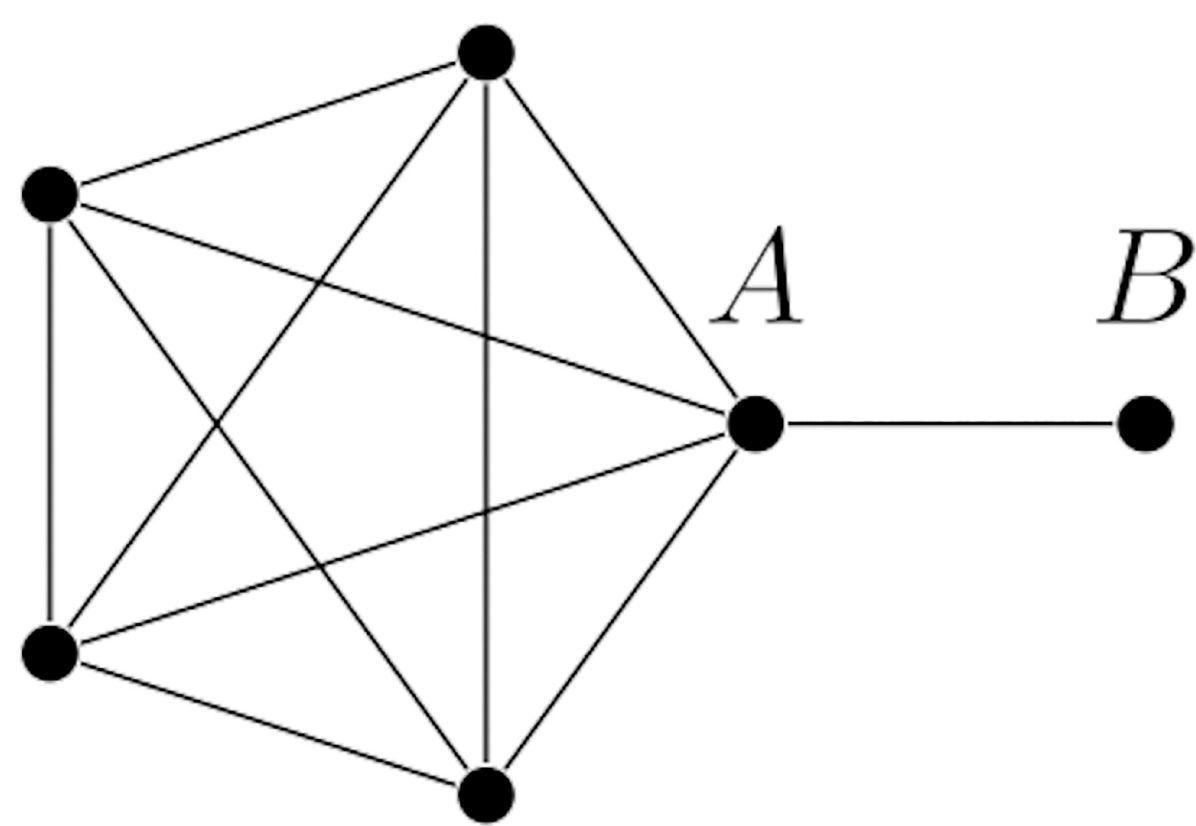
Fig 4. A graph constructed from a complete graph on k = 5 nodes by adding a new